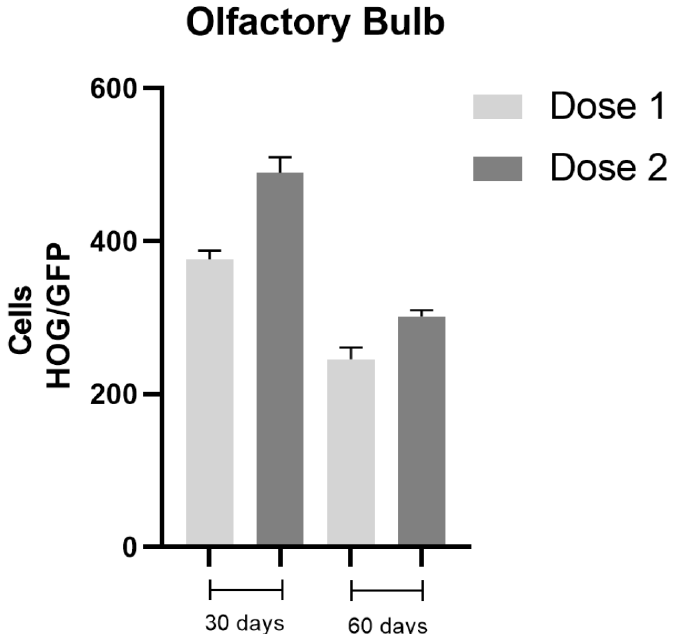
Figure 2. Analysis of cell density in the olfactory bulb. HOG cells were detected in the olfactory bulb, independently of the dose administered; this suggests that the cells are able to cross the cribriform plate, forming clusters near capillaries and apparently integrating into the neuropil. Data are expressed as means + SE.